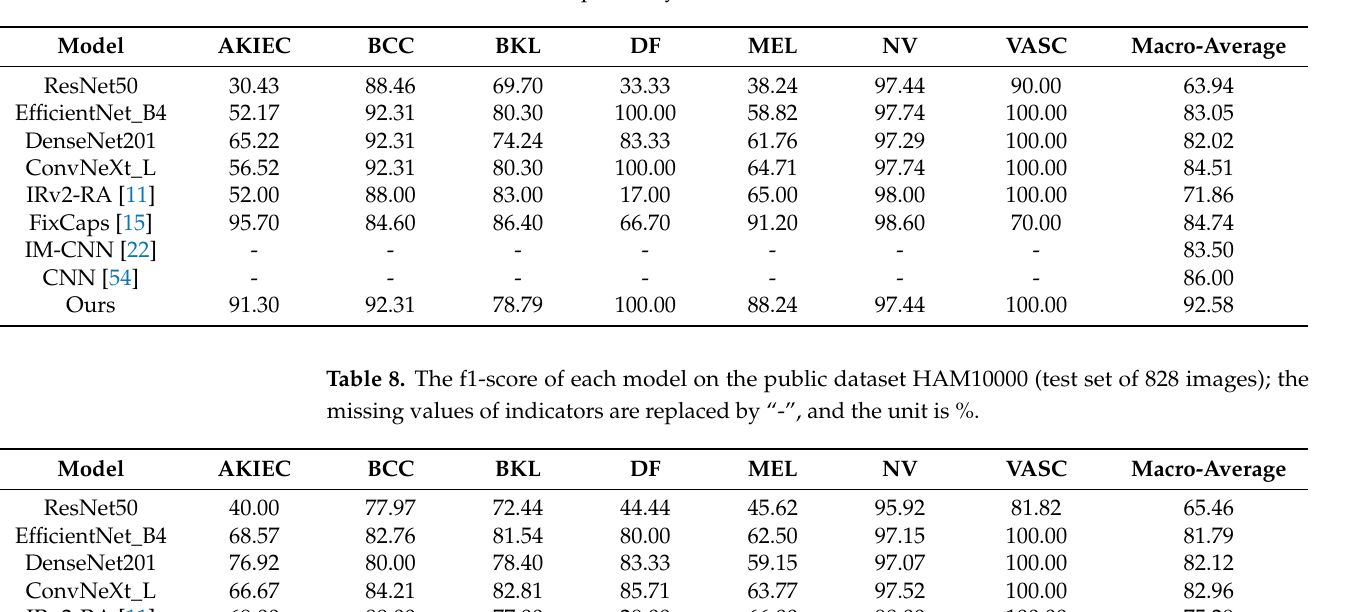
Table 7. The recall of each model on the public dataset HAM10000 (test set of 828 images); the missing values of indicators are replaced by “-”, and the unit is %.